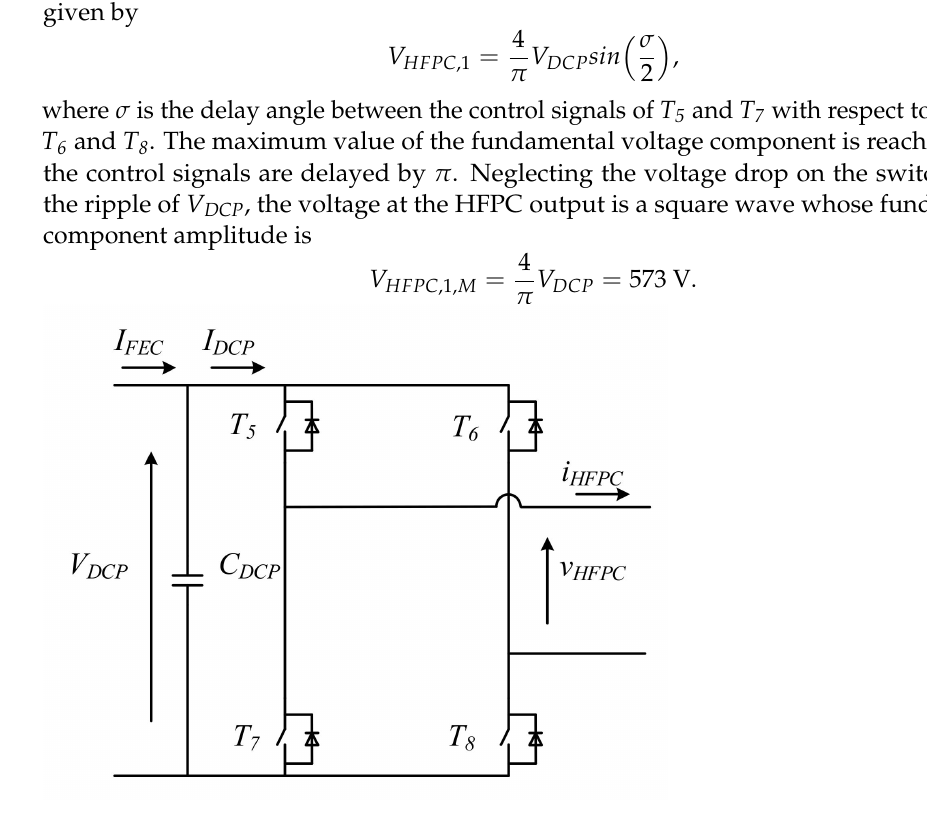
Figure 8. Schematics of the HFPC and convention of the current according to charging mode.